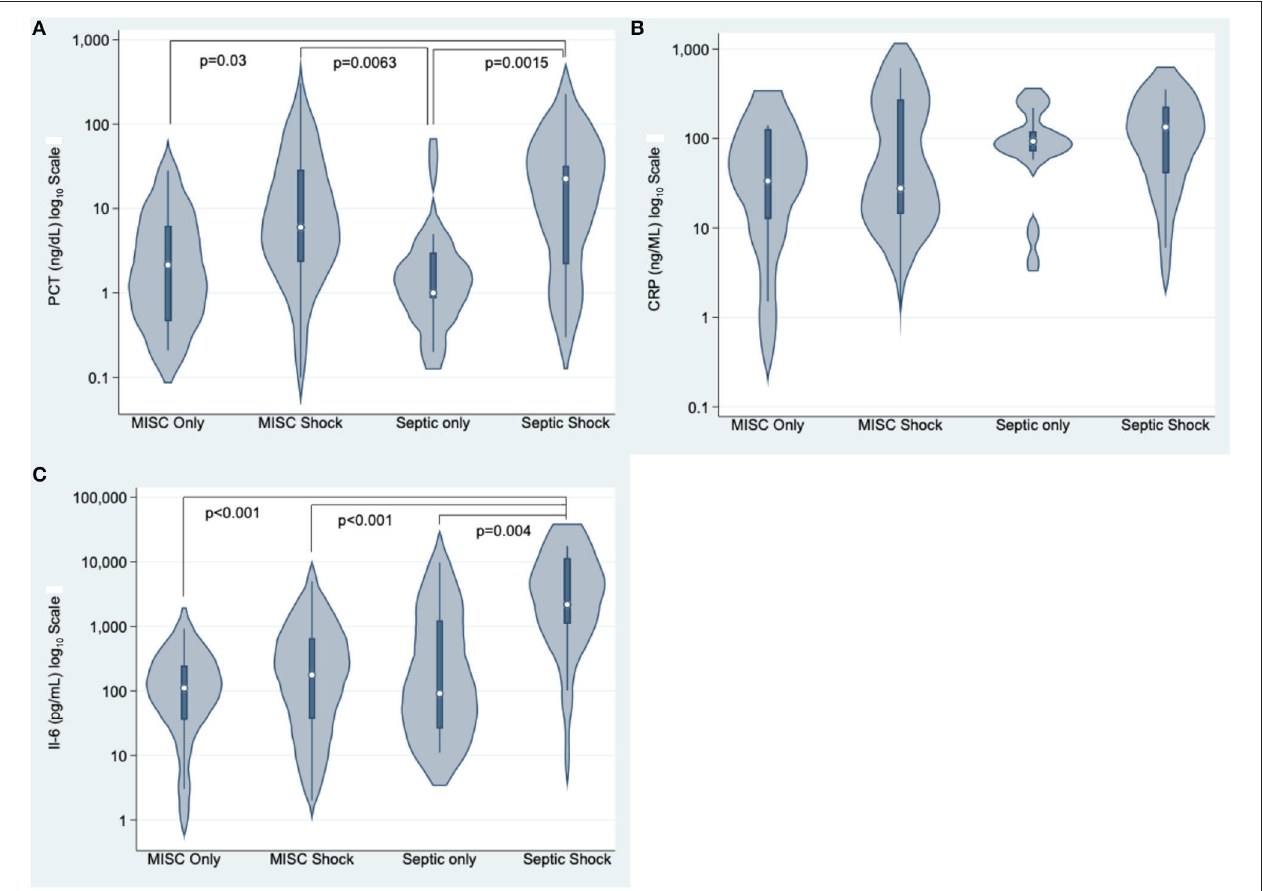
FIGURE 1 | Procalcitonin (PCT, ng/dl) (A) , C-reactive protein (CRP, ng/ml) (B) , and Interleukin 6 (IL-6, pg/ml) (C) in critically ill children with MIS-C, MIS-C shock, sepsis, and septic shock. p values after Dunn’s test with Bonferroni correction for group comparisons, p < 0.05 are